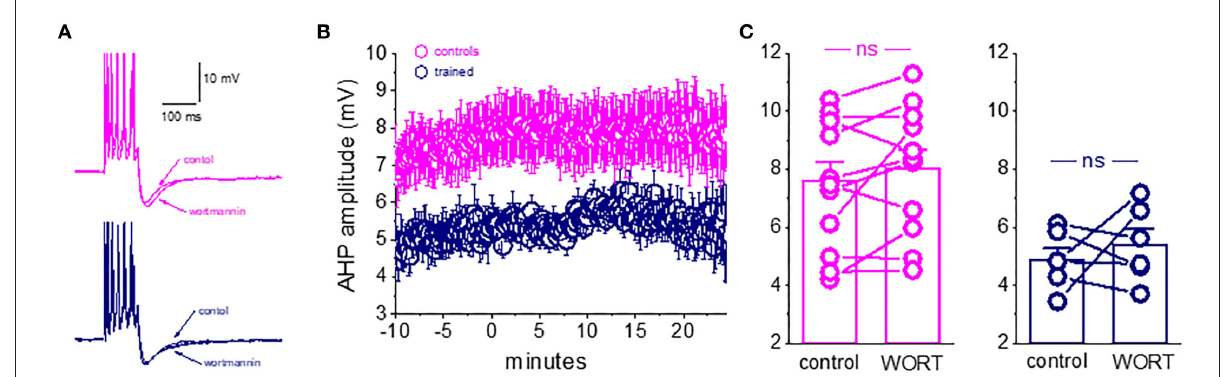
FIGURE5 Blocking PtdIns(4,5)P(2) biosynthesis does not affect the post-burst AHP amplitude. (A) Averaged traces from pseudo-trained and trained neurons, before and 20min after wortmannin application. Wortmannin had no effect on the post-burst AHP in both neurons. (B) Timeline of continuous AHP recordings before ( − 10 to 0min) and after wortmannin application in neurons from control and trained rats. Values represent mean ± SE. (C) Direct comparison of the AHP values in each cell before and 20min after wortmannin application in neurons from control and trained rats. Wortmannin did not change the post-burst AHP amplitude in controls or trained neurons. Values represent mean ± SE. The paired t -test was used to compare the effect of wortmannin on each group of neurons. ns, not significant.